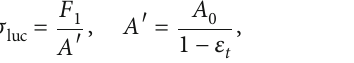
(Table 2). Speci fi c heat capacity, C v ð J/kg ∘ C Þ , indicates the